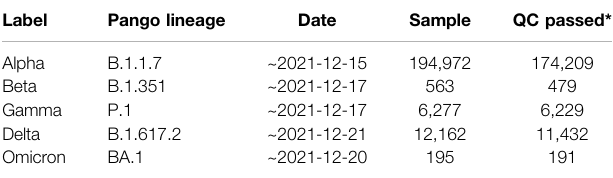
TABLE 1 | SARS-CoV-2 sample